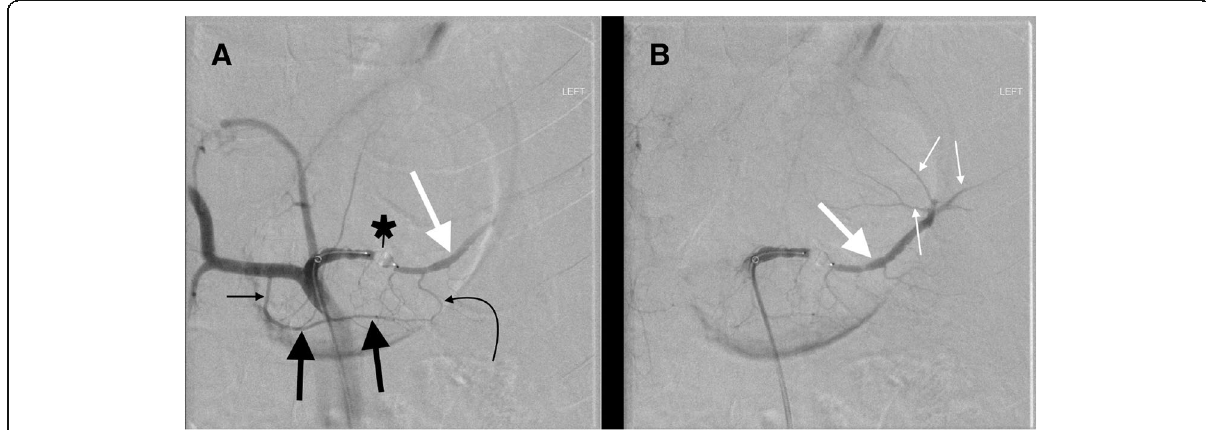
Fig. 3 32 year old male in a snowmobile verses truck accident. a Celiac DSA after proximal splenic artery embolization with an AMPLATZER ™ Plug (black star). Note the dorsal pancreatic artery (thin straight black arrow) originates from the common hepatic artery, a variation that occurs in approximately 20% of cases. Blood from the dorsal pancreatic artery then travels left along the transverse pancreatic artery (thick black arrows). Blood then flows retrograde up the great pancreatic artery (curved black arrow) reconstituting the mid/distal splenic artery (thick white arrow). b Subsequent image shows reconstituted flow in the mid/distal splenic artery (thick white arrow) with opacification of splenic artery branches (thin white